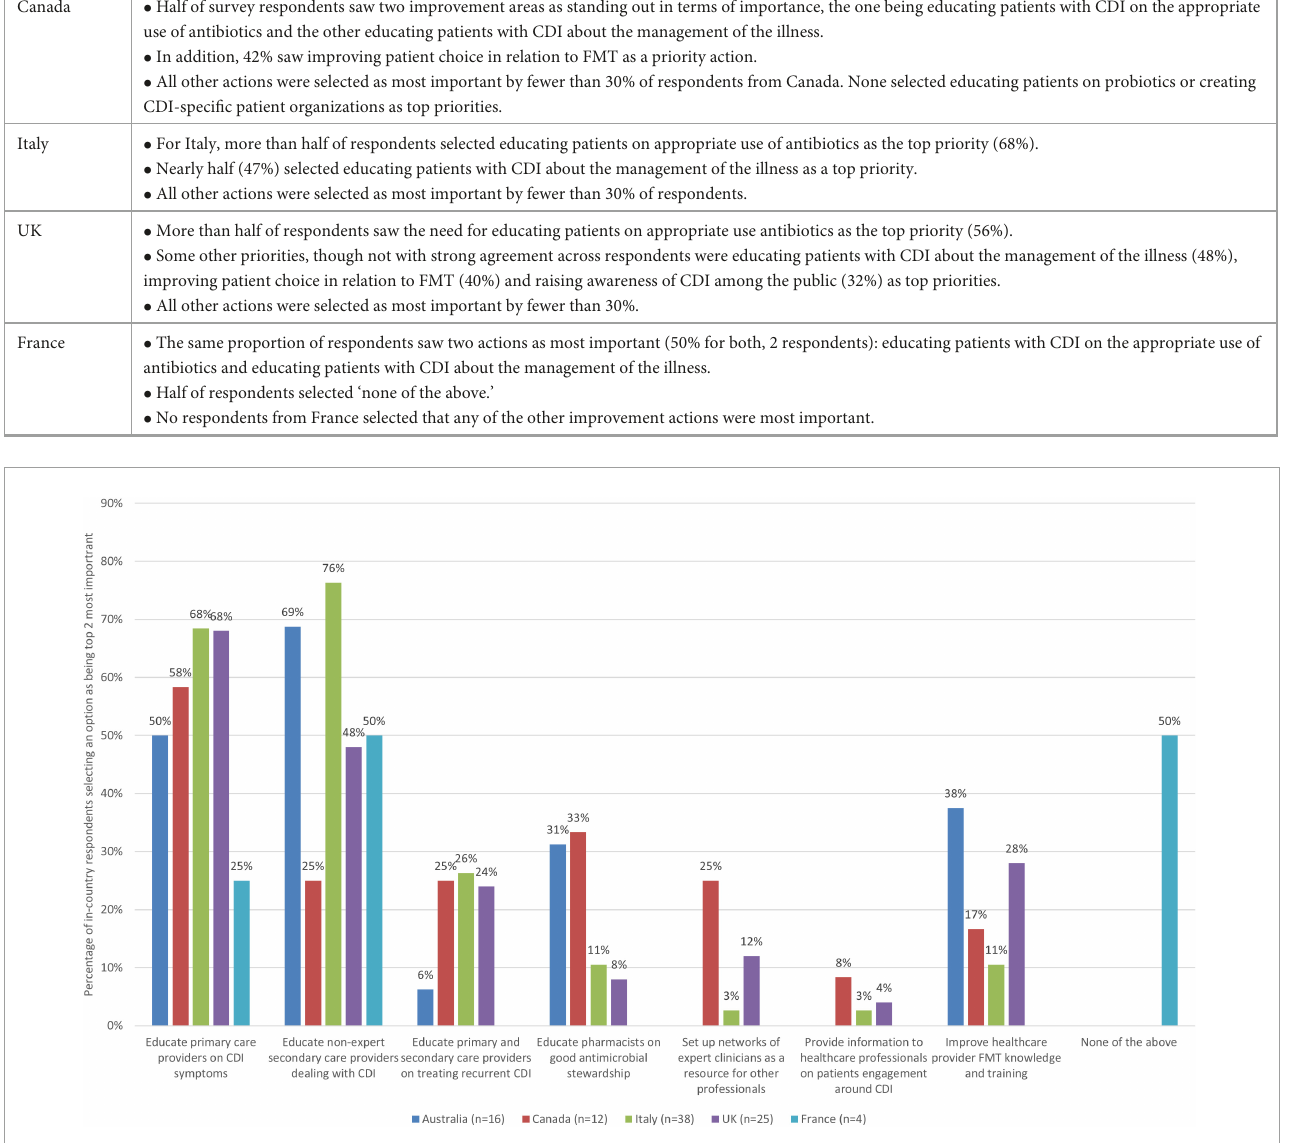
FIGURE5 The 2 improvement actions related to education and awareness raising for clinicians that are the most important (bars represent the percentage of respondents that rated each improvement action as one of the most important by